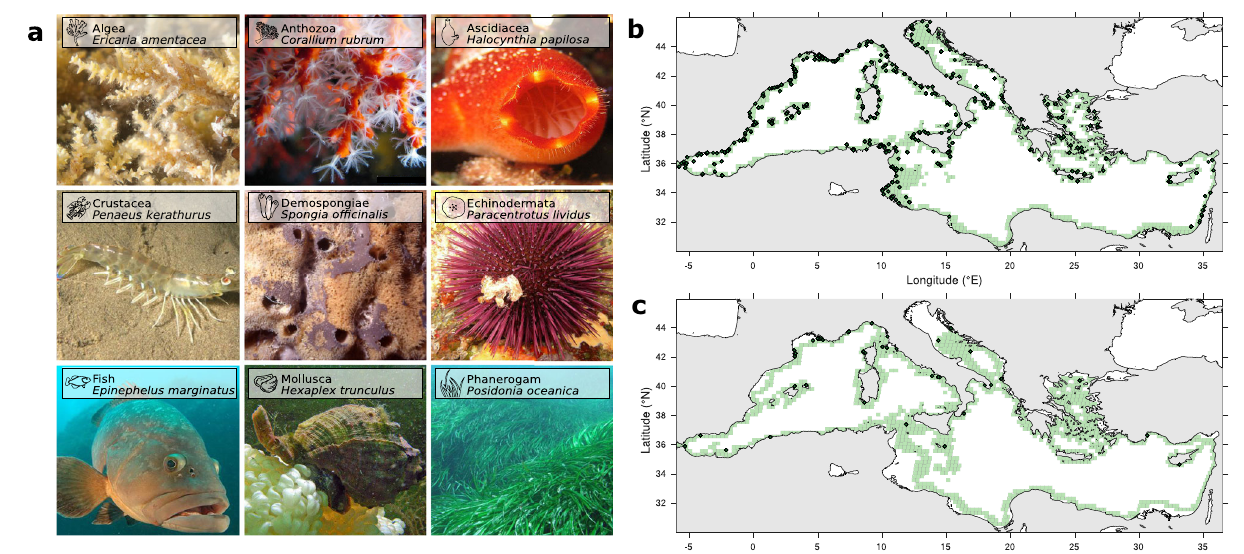
c , same as b but for the neritic shelf habitat. Source data are provided as a Source Data fi le. Photos credit (from left to right, top to bottom): © Veronique